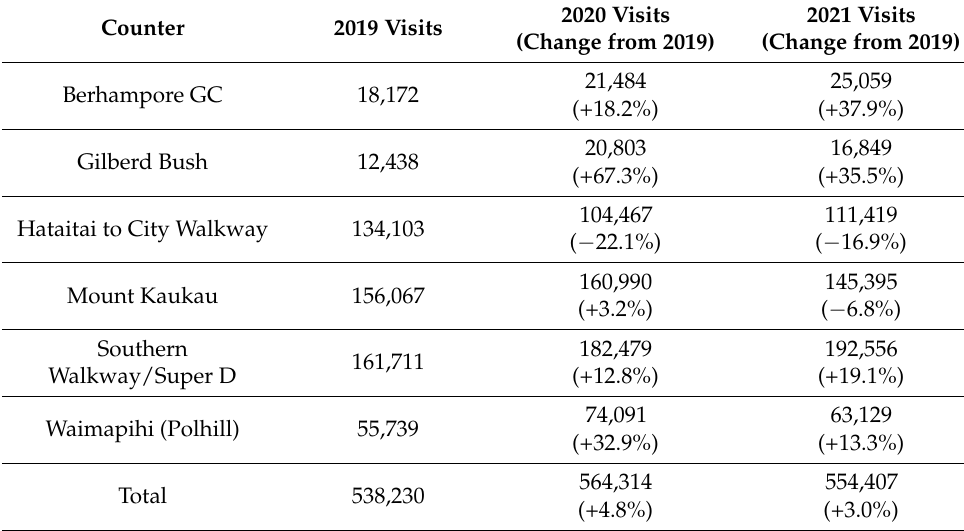
Table 1. Summary of green space visits in 2019 (pre-COVID), 2020, and 2021. Counter